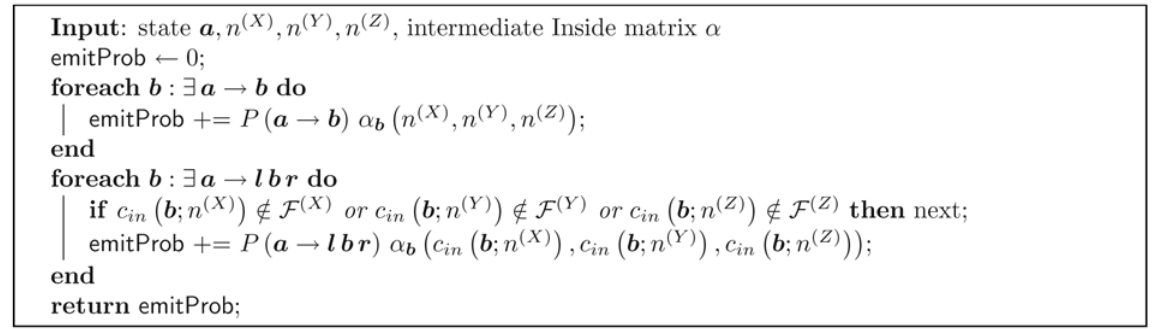
Figure 2. Algorithm 2. Subroutine calcTransEmitProb() for the Inside algorithm. a and b are ensemble states; l and r are left and right terminal emissions.